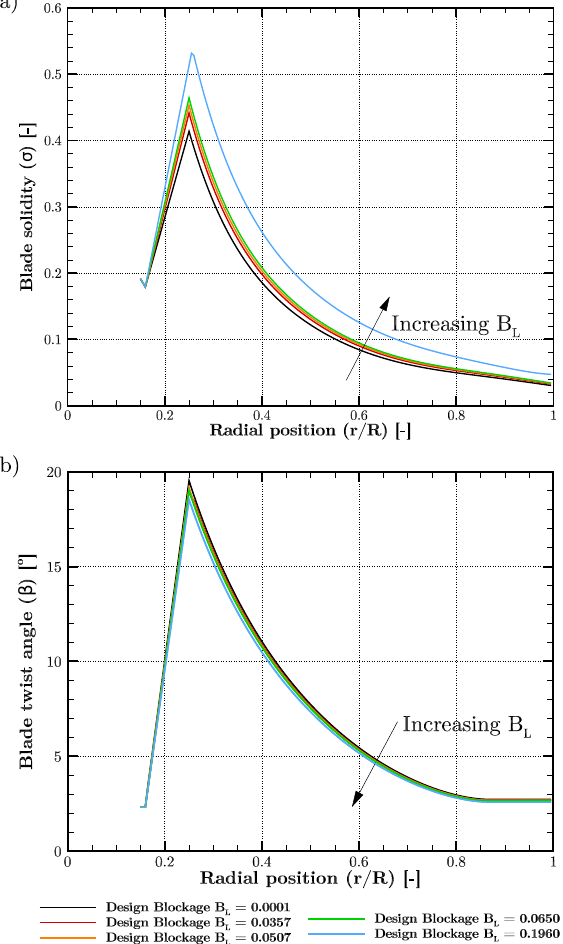
Fig. 2. Blade solidity, σ , (a) and blade twist angle, β , (b) for the five rotor designs for local blockage ratios B L = 0 . 0001 (black), B L = 0 . 0357 (red), B L = 0 . 0507 (orange), B L = 0 . 0650 (green), and B L = 0 . 1960 (blue). Solidity increases with increasing B L , whereas the blade twist angle